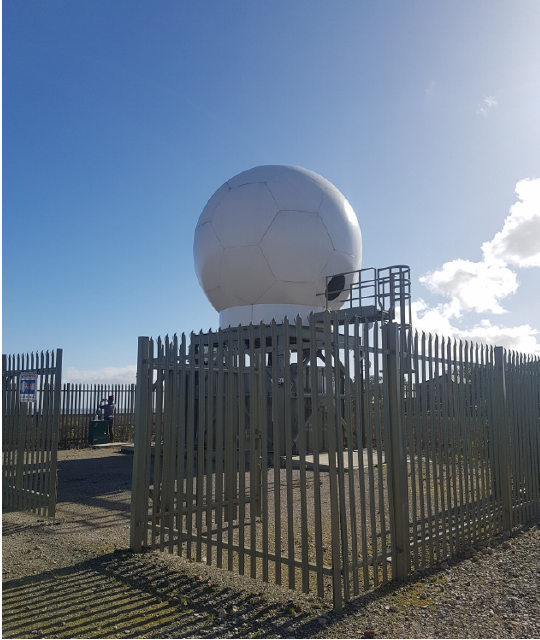
Figure 2. Doppler radar unit deployed on the shore of the Westermost Rough wind